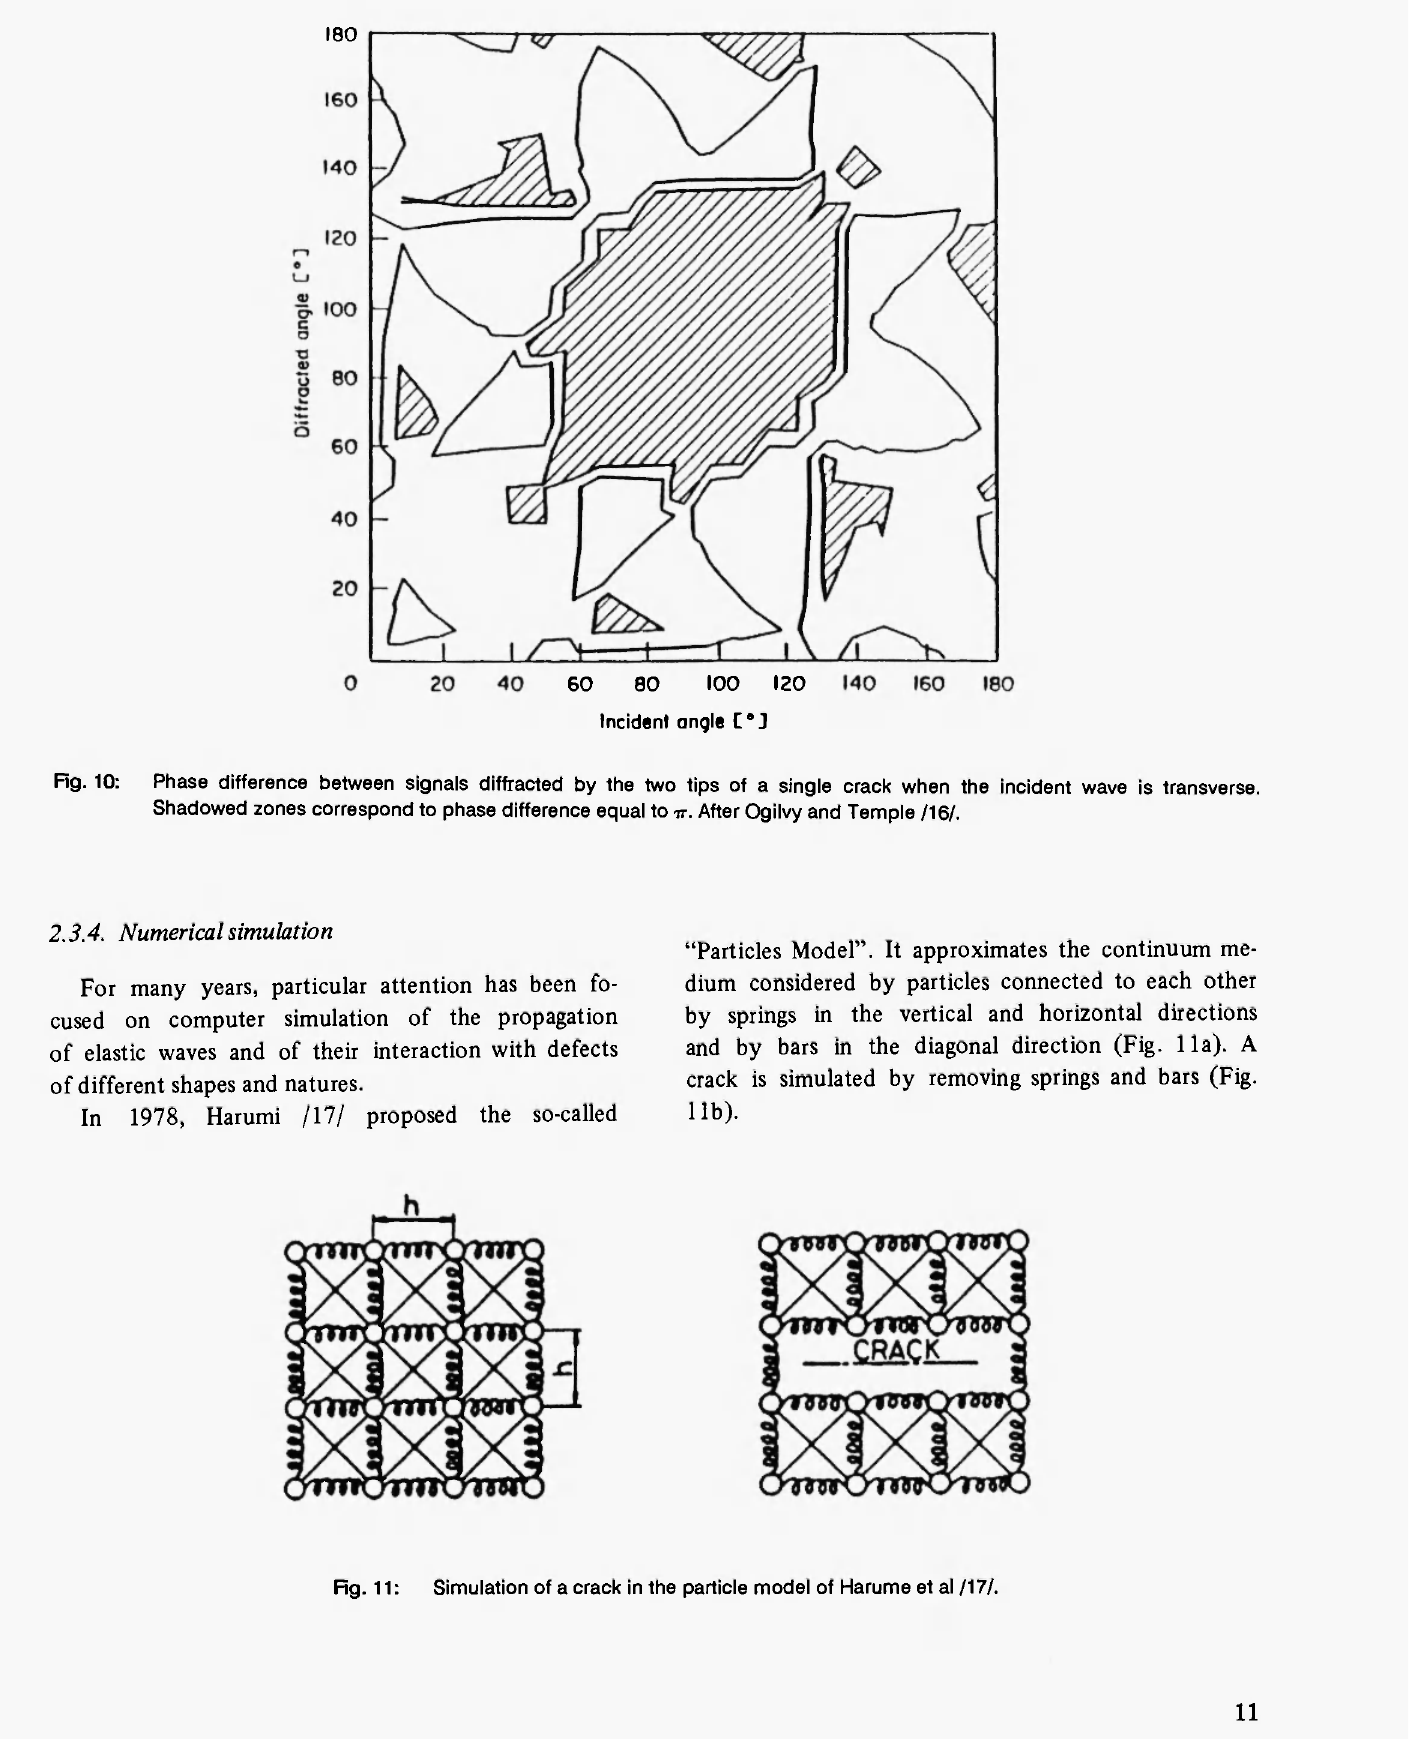
Fig. 11: Simulation of a crack in the particle model of Harume et al